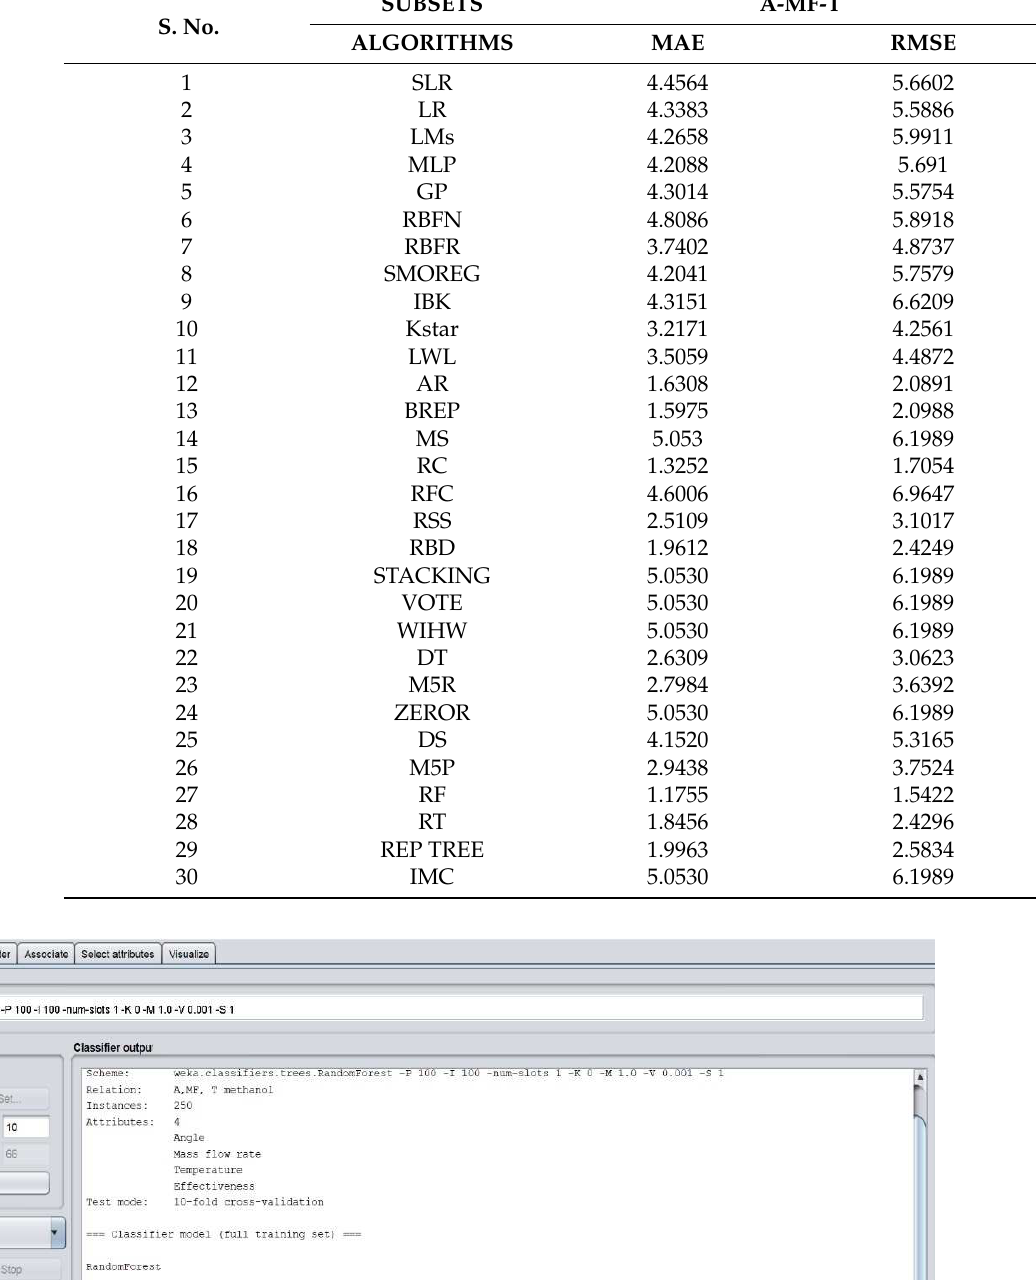
Table 7. Subsets with one parameter—Performance.